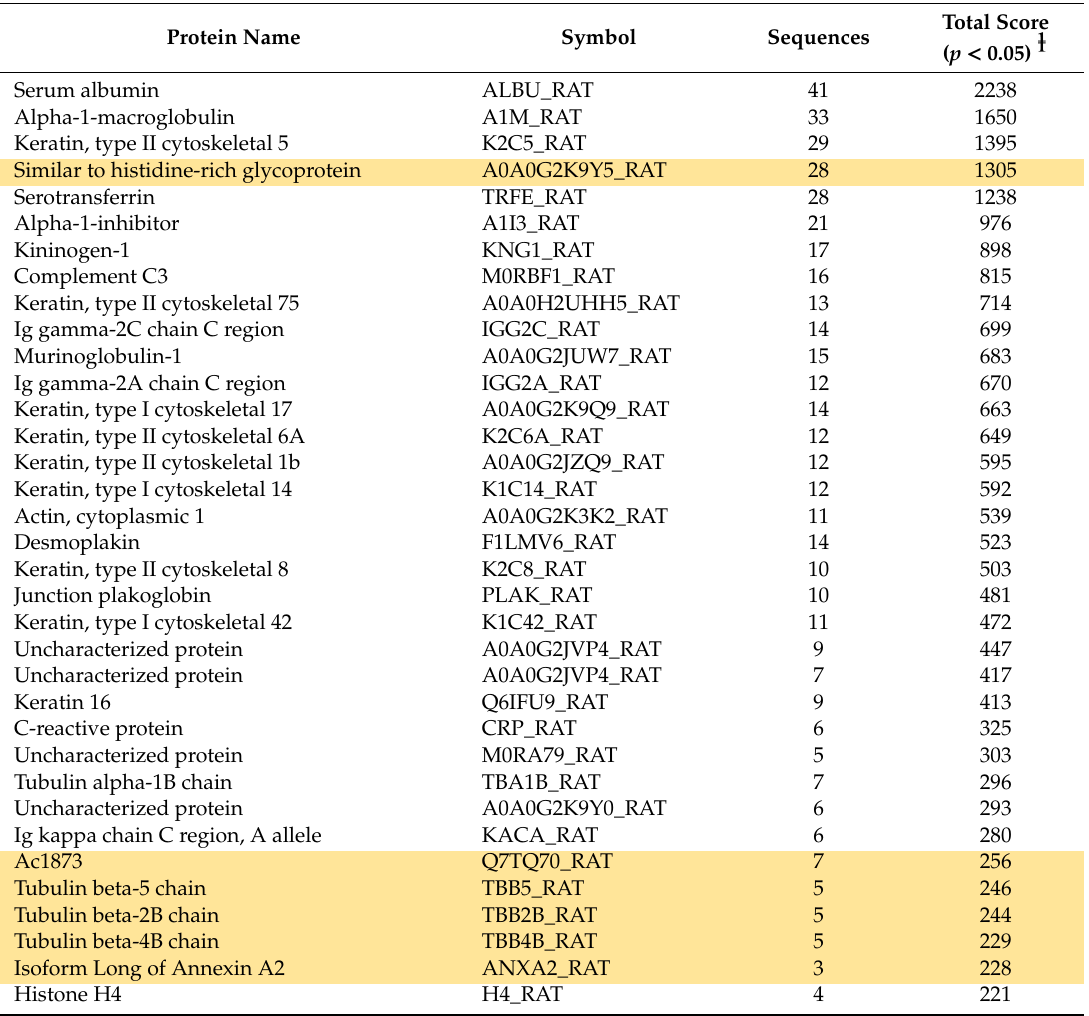
Table 4. Deiminated proteins in plasma-EVs of pre-motor PD rats ( Rattus norvegicus ), as identified by F95-enrichment and LC-MS / MS analysis. Deiminated proteins in pre-motor PD rat plasma were isolated by immunoprecipitation using the pan-deimination F95 antibody. The resulting F95-enriched eluate was then analysed by LC-MS / MS and peak list files submitted to mascot. Rattus norvegicus species-specific peptide sequence hits are listed, showing number of sequences for protein hits and total score. Orange highlighted rows indicate protein hits identified in plasma-EVs of pre-motor PD rats, but not in plasma-EVs of sham-treated